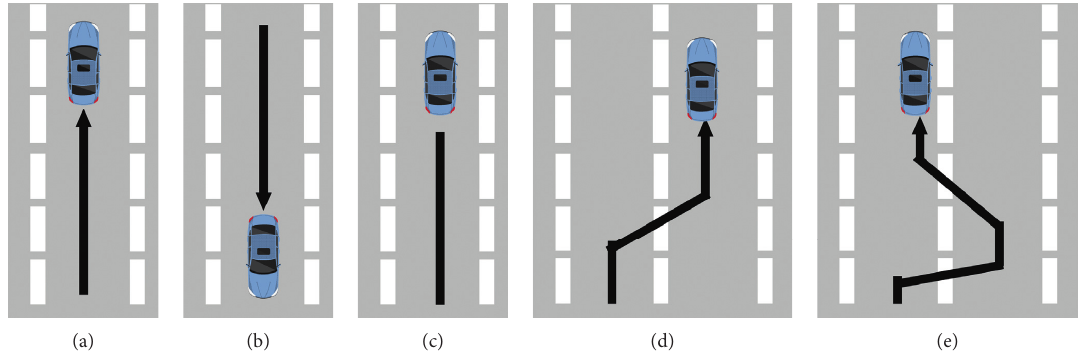
Figure 9: Schematic diagram of the semantic expression of the vehicle trajectory used in this study. (a) Trajectory of normal driving, (b) trajectory of reverse, (c) trajectory of parking, (d) trajectory of changing lanes, and (e) trajectory of overtaking.